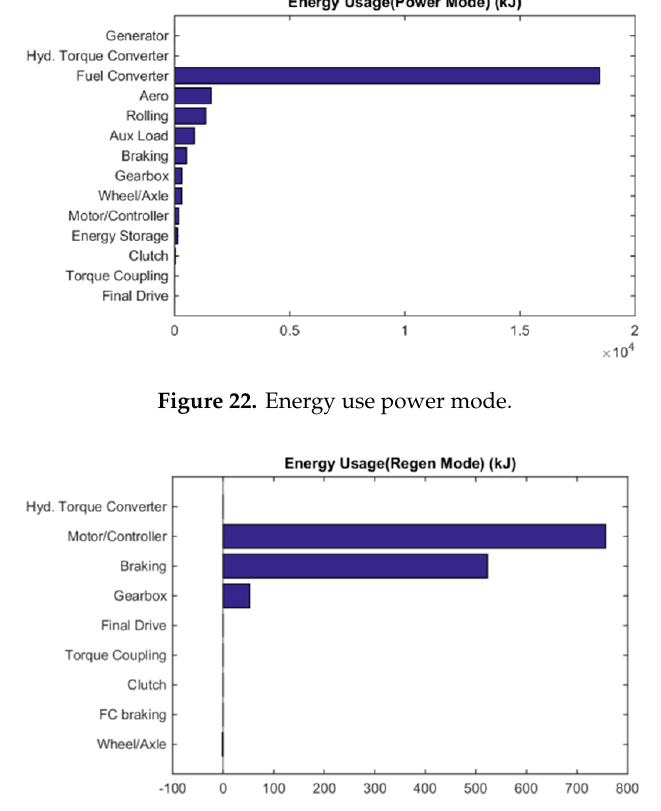
Figure 23. Energy use regeneration (regen) mode.